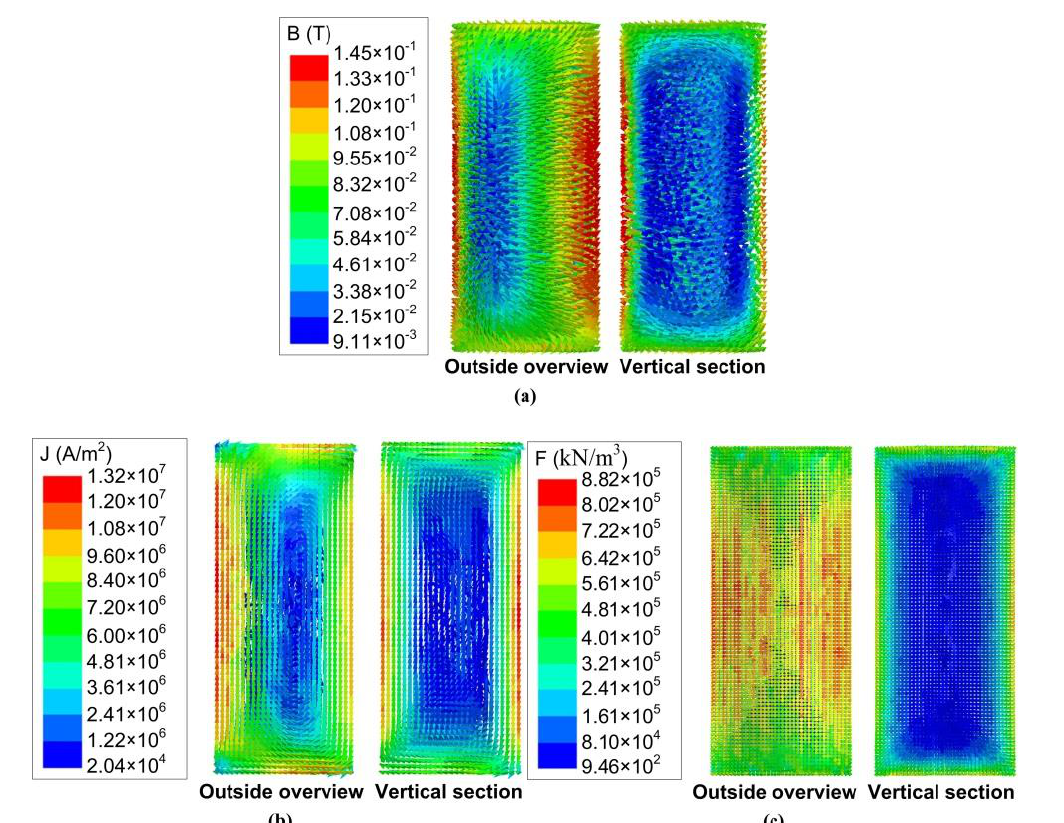
Figure 8. Results of ( a ) electromagnetic intensity, ( b ) induced current density, and ( c ) Lorentz force distributions—winding current: 50 A; electrical frequency: 50 Hz; phase angle: 0°.